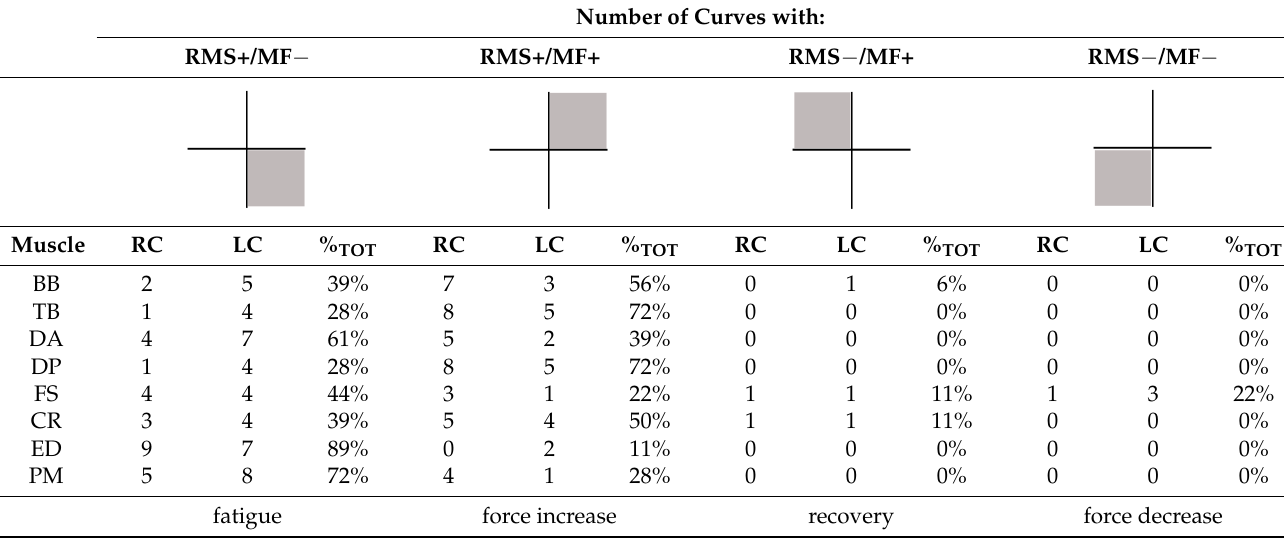
RC: right curves; LC: left curves; % TOT : the percentage of occasions when the muscle showed such a behavior; BB: biceps brachii; TB: triceps brachii; DA: anterior part of the deltoid; DP: posterior part of the deltoid; FS: flexor digitorum superfi-